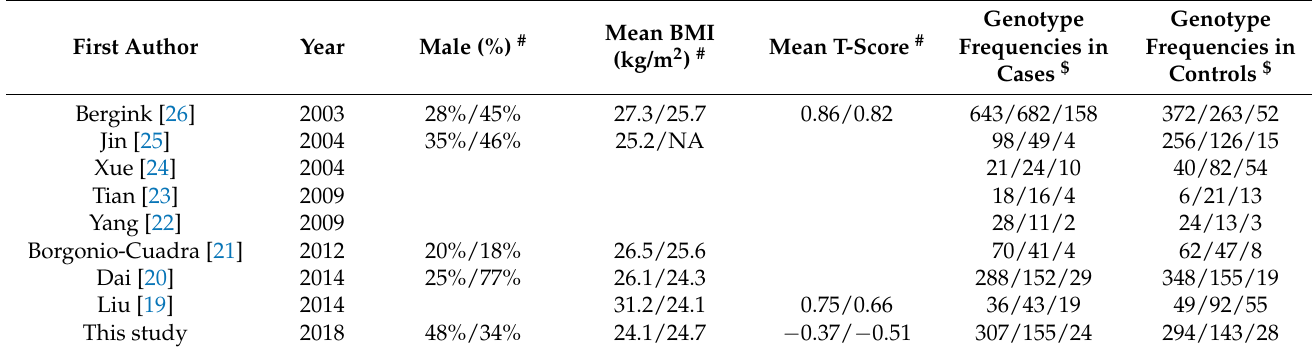
Table 4. The population information of included studies.